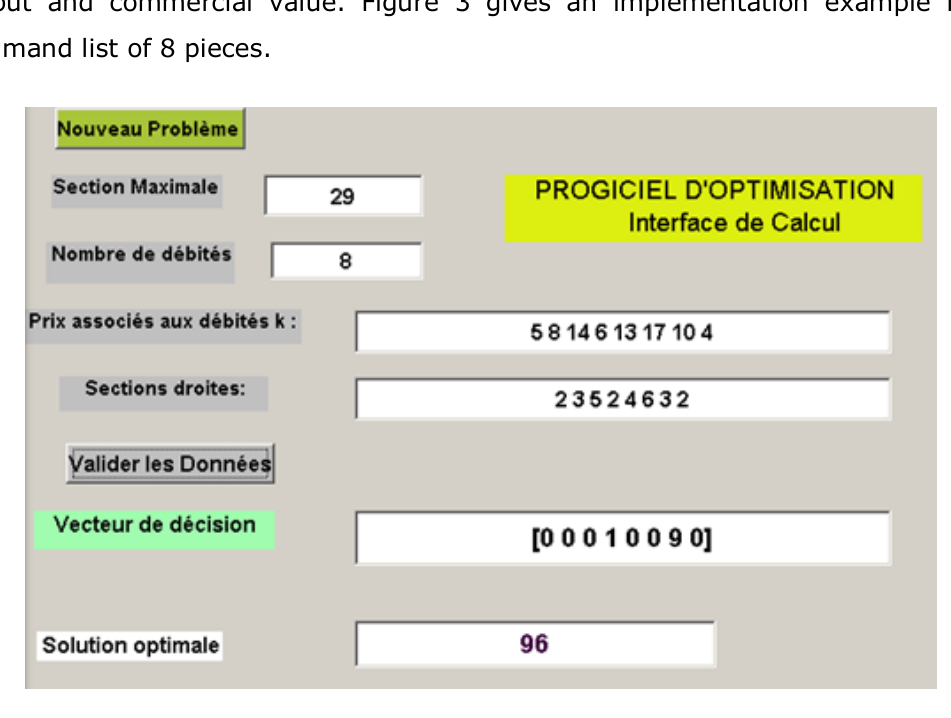
Figure 3. Implementation for a list of